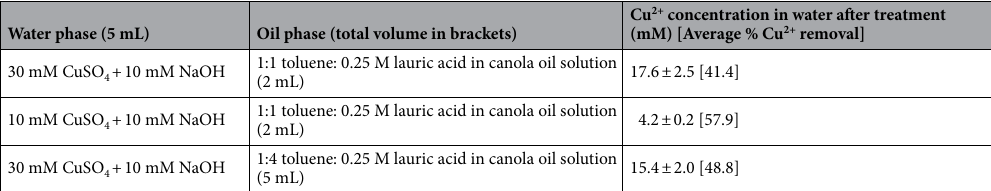
Table 8. ICP analyses of the water phase of samples prepared starting with 30 mM CuSO 4 and 10 mM CuSO 4 , using toluene and lauric acid solutions in canola oil. The volumes used and the lauric acid concentrations are as indicated in the table. Partitioning of copper ions in the toluene phase with lauric acid and a base is also achieved without using canola oil, as qualitatively assessed based on the discoloration of the toluene phase (Fig. S13, supporting information). Measurements were done after 24 h